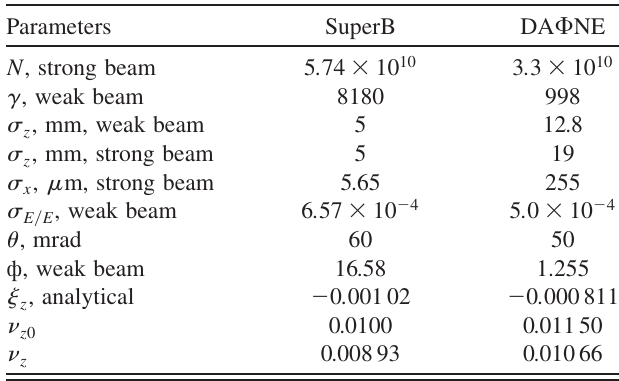
TABLE I. DA(cid:1)NE and SuperB parameters and synchrotron tune